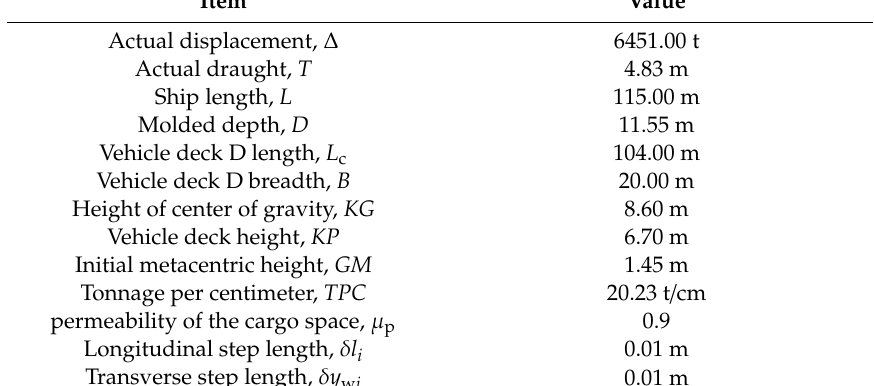
Table 3. The particulars of the loading conditions of the M/V Dashun at the time of the accident.